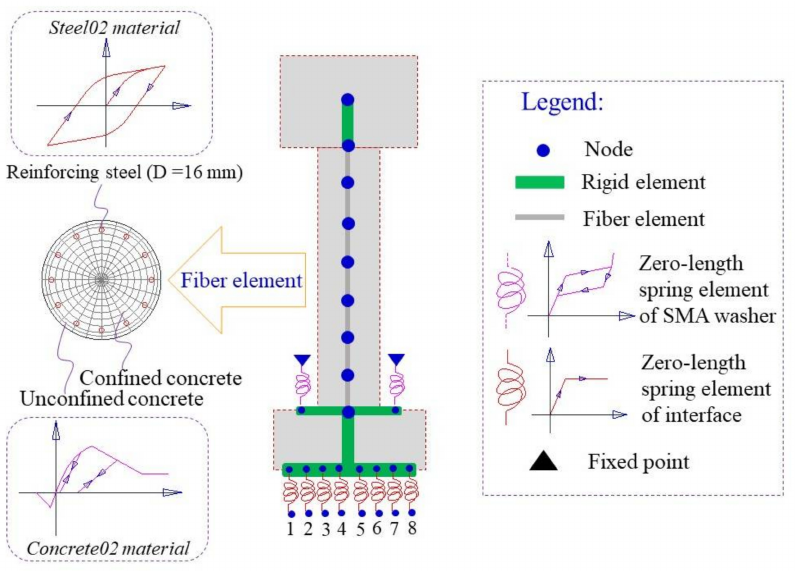
Figure 10. FE model of the rocking pier specimen.